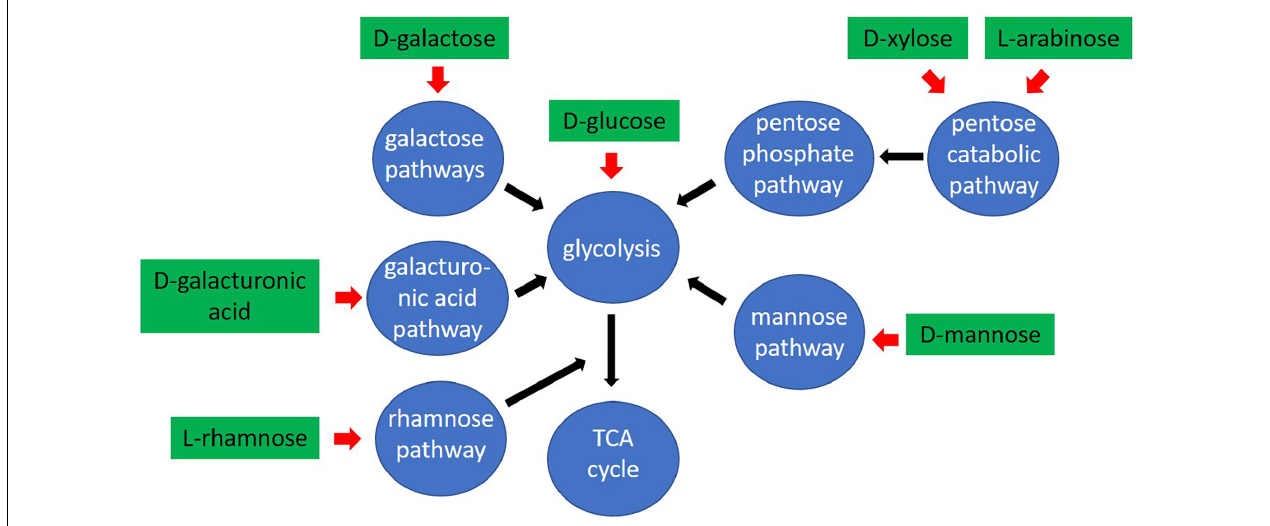
FIGURE 7 | Schematic overview of the pathways used by Aspergillus niger to convert plant biomass derived monosaccharides.